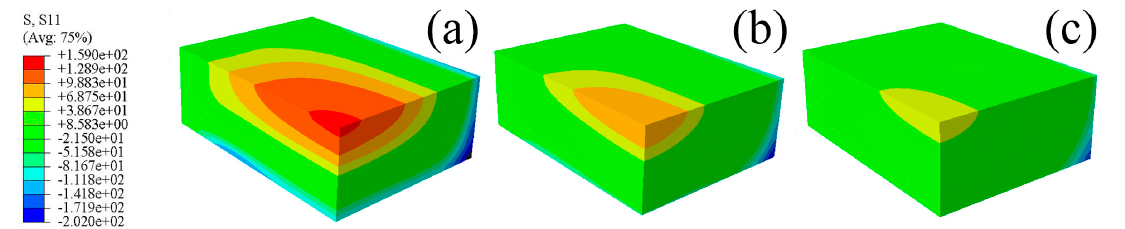
Figure 11. The cooling rates of the points of W/2024Al composite blocks quenched by water of different temperatures; ( a ) The point of maximum compressive stress; ( b ) The point of maximum tensile stress.